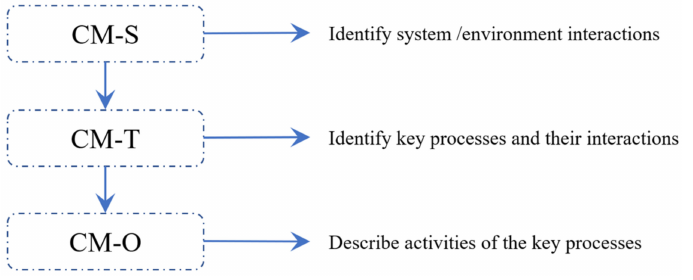
Figure 11. Conceptual Model in the Layered Template